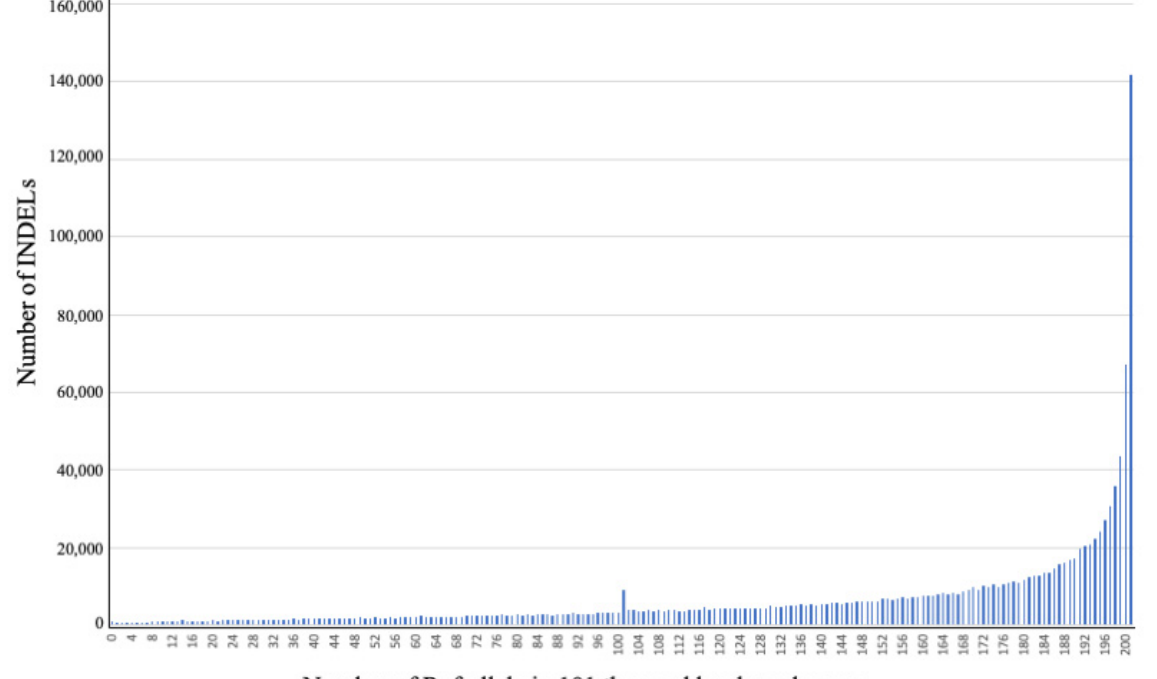
Figure 3. Allelic distribution of 1,274,708 diallelic insertions and deletions (INDELs) identified on autosomes (chromosomes 1–31) in 101 Thoroughbred racehorses. The horizontal axis indicates the number (frequency) of Ref alleles in the population (202 alleles in total), meaning that the right edge shows a MAF of 0.00495 for Alt allele, the centre shows a MAF of 0.5, and the left edge shows a MAF of 0 (Alt/Alt genotypes in all horses).